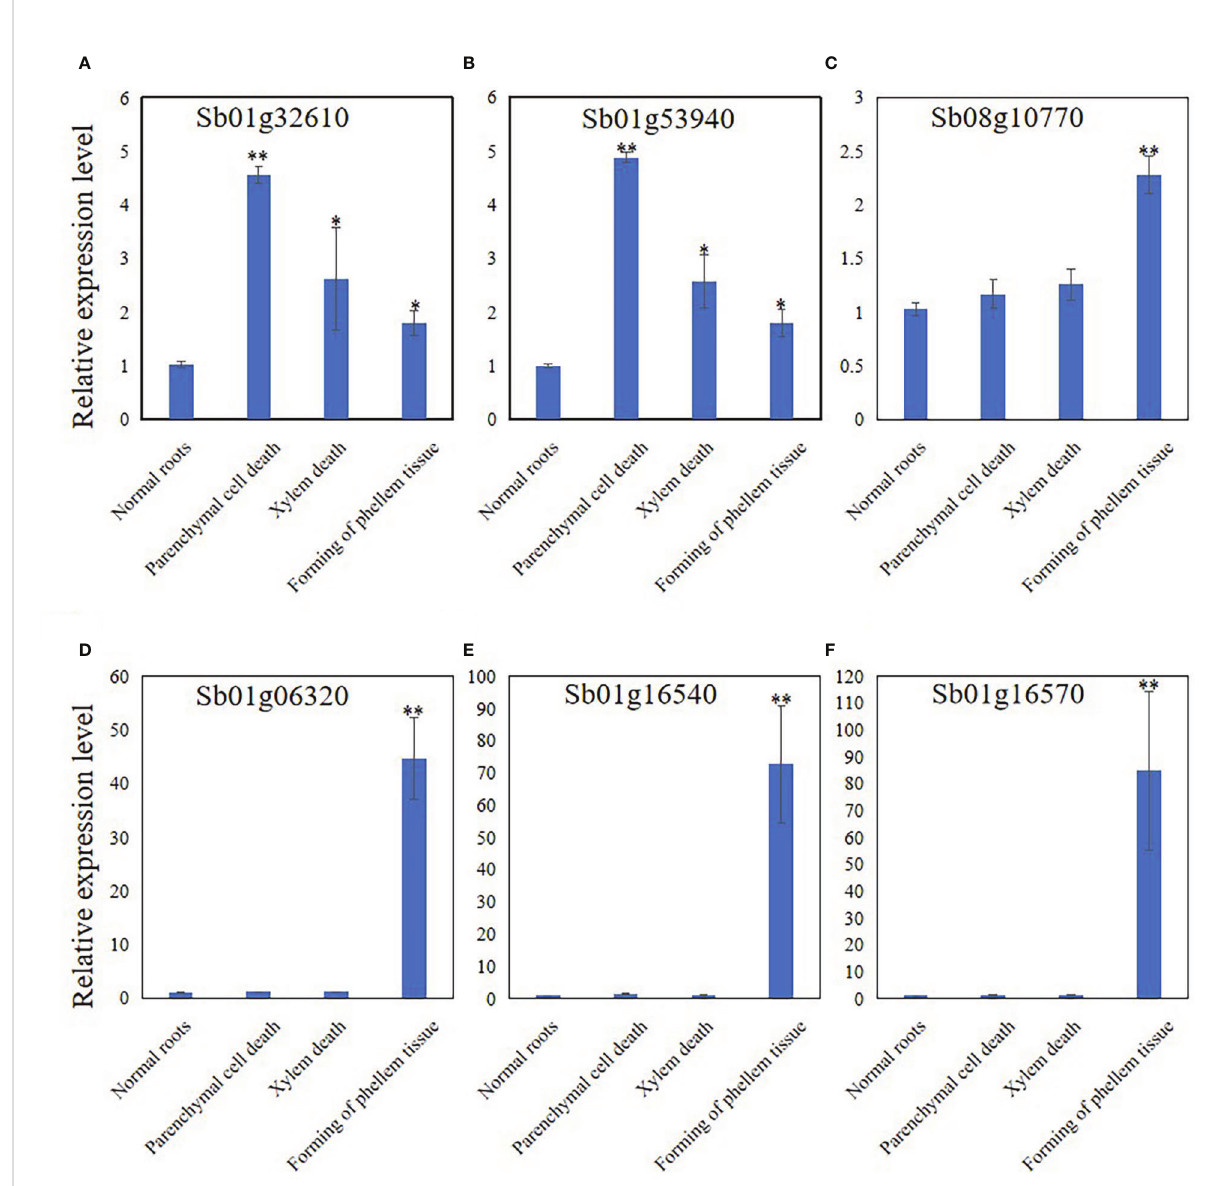
FIGURE 6 Relative expression level of Sb01g32610 (A) , Sb01g53940 (B) , Sb08g10770 (C) , Sb01g06320 (D) , Sb01g16540 (E) and Sb01g16570 (F) in root of 4 stages during hollowed roots development. The relative expression level were calculated by Delta-delta Ct values. The data are the means ± SDs (n = 3). *means p < 0.05, **means p <